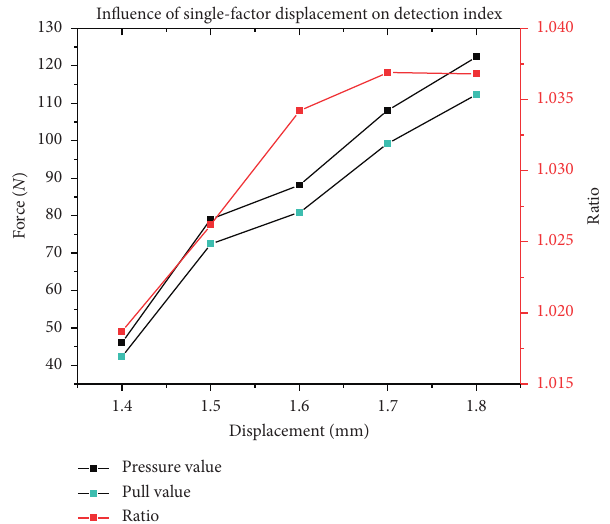
Figure 7: Impact of different displacements on detection indexes.